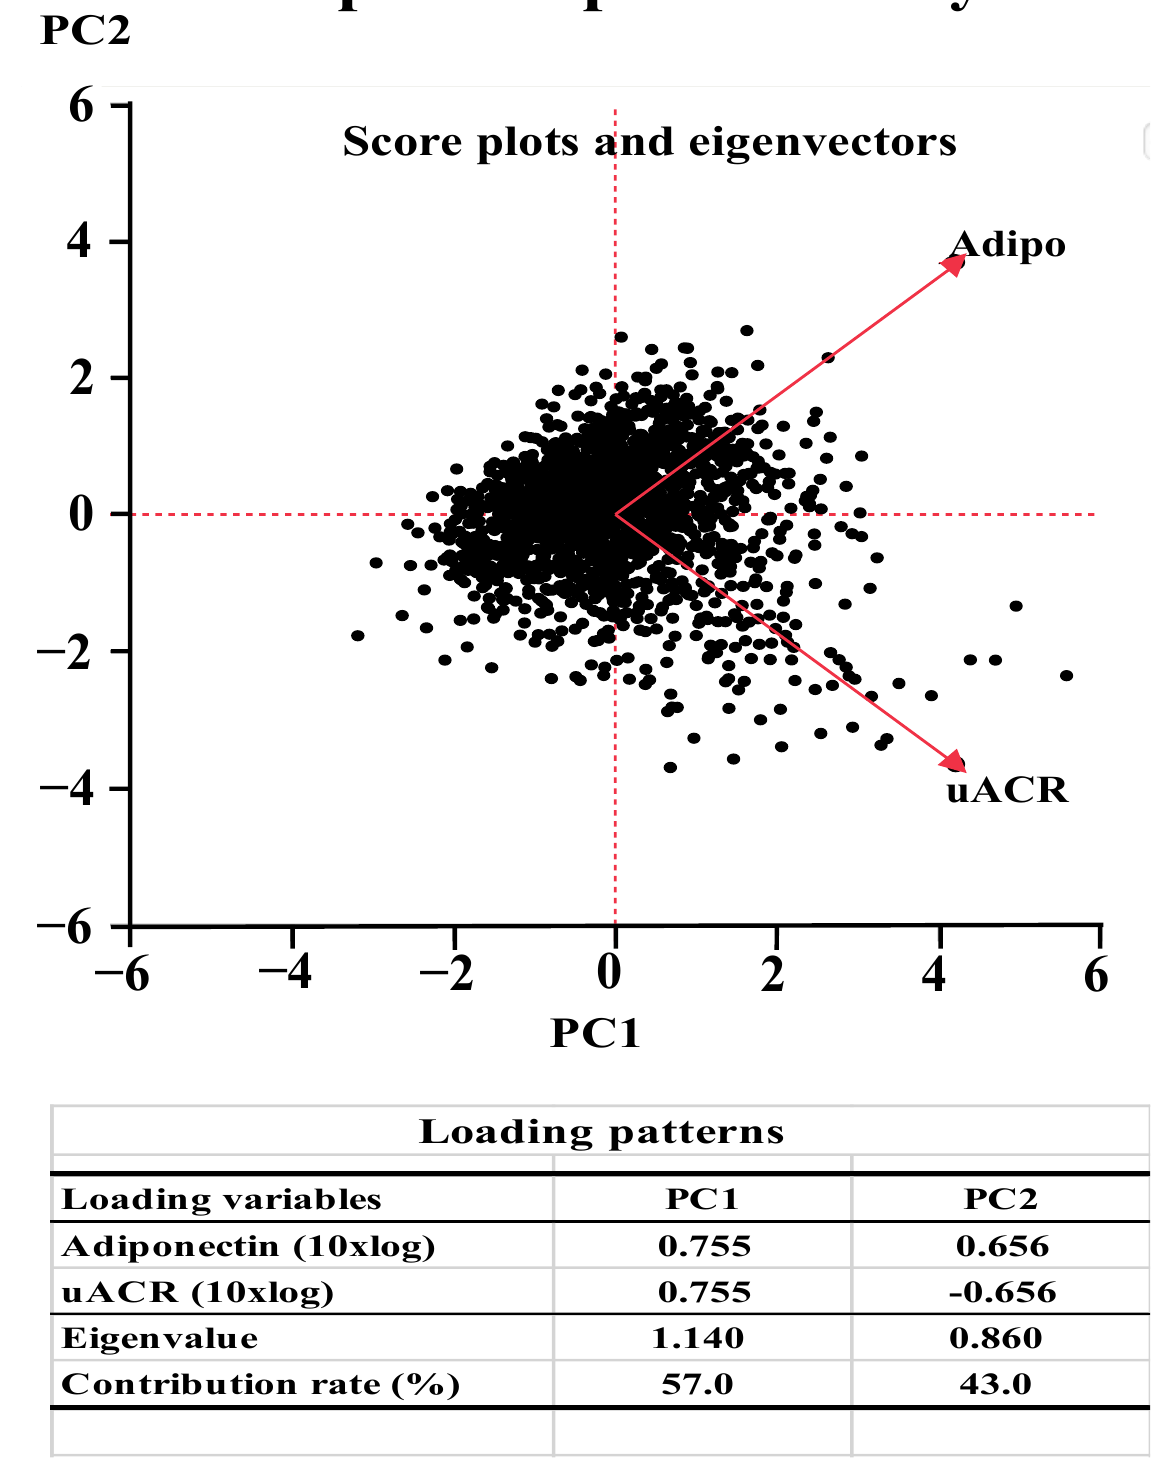
Figure 1. Results of the principal components (PCs) analysis using serum adiponectin concentration (Adipo) and urinary albumin/creatinine ratio (uACR). Eigenvectors with the score plots and loading patterns of PCs are shown in the upper and lower panels, respectively. Adipo and uACR were log-transformed for the analysis to normalize their distributions.